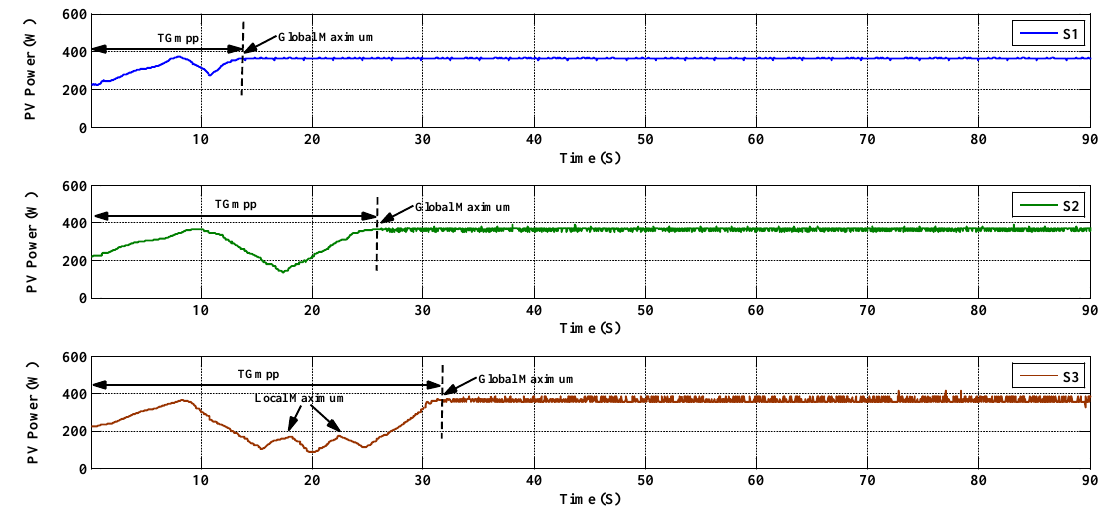
Figure 27. PV output power for the scenario of Figure 26.